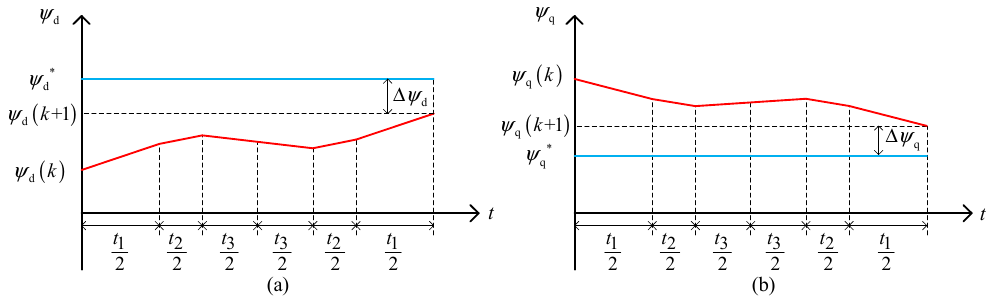
Ψ Ψ q with the switching sequence d and ( b )